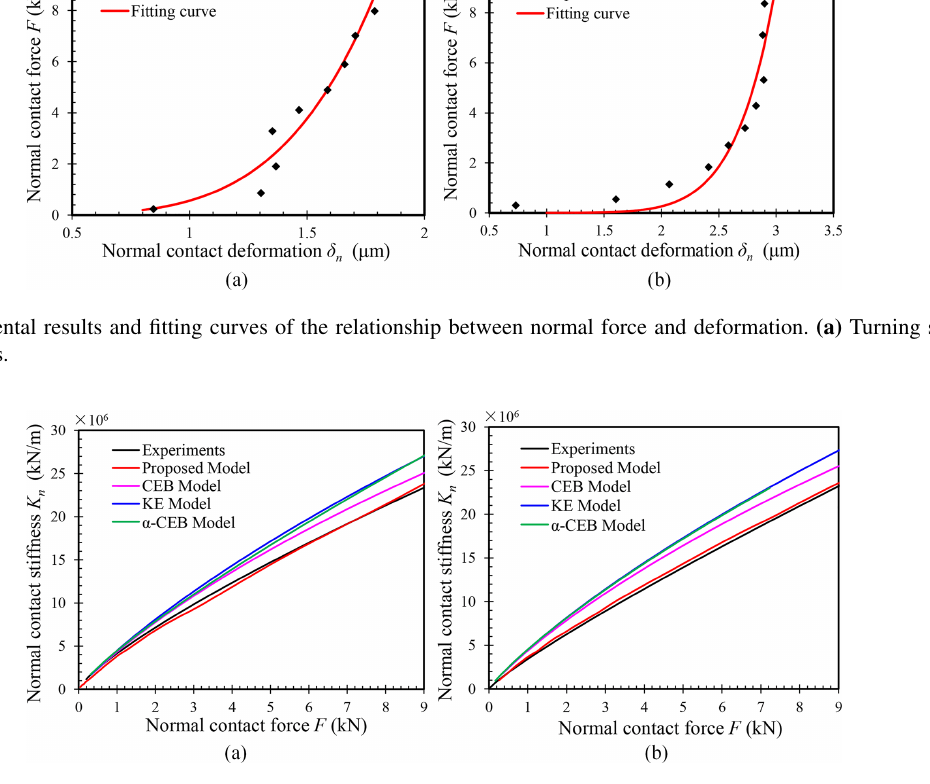
Figure 14. Comparison of normal contact stiffness predicted by a theoretical model and experimental results. (a) Turning specimens and (b) milling